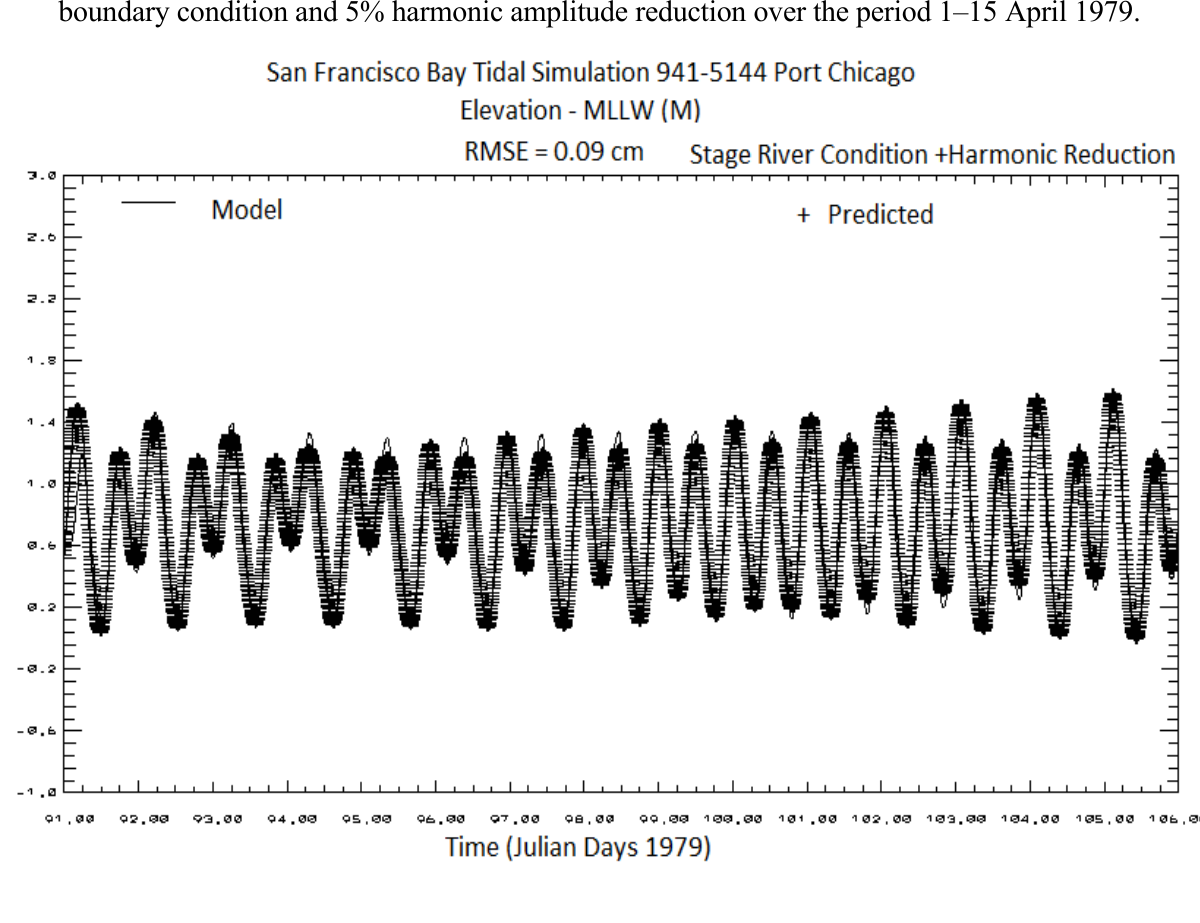
Figure 5. Comparison of modeled versus predicted water level at Port Chicago with stage boundary condition and 5% harmonic amplitude reduction over the period 1–15 April